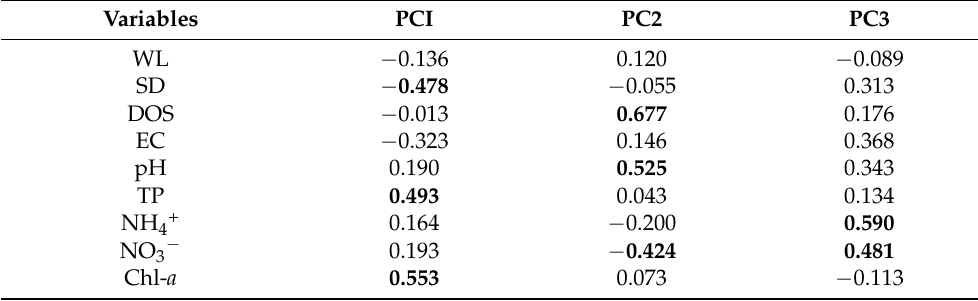
Table 2. Loadings, eigenvalues, and PCA variance. Loadings greater than |0.4| and eigenvalues greater than 1 in each PC are in bold. WL = water level, SD = Secchi disk depth, DOS = dissolved oxygen saturation, pH = hydrogen potential, EC = electrical conductivity, NH 4+ =